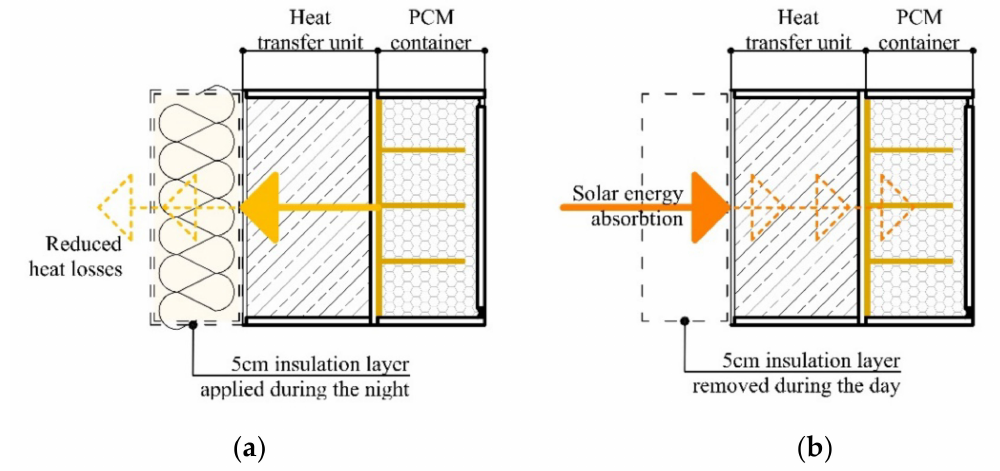
Figure 2. Charging phase with no insulation layer ( a ) and discharging phase with an insulation layer ( b